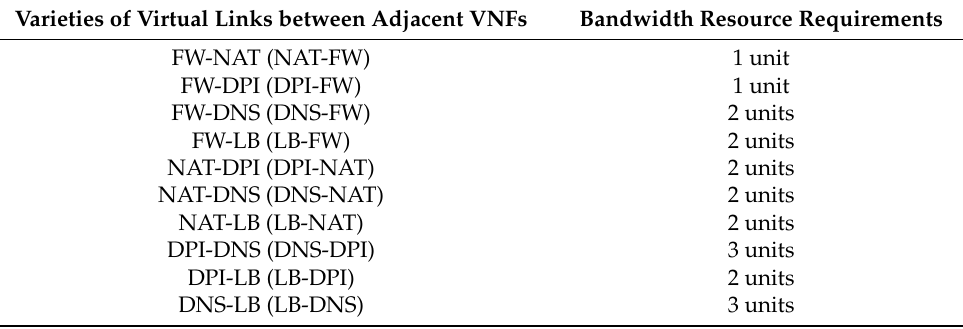
Table 3. All virtual links and their respective bandwidth resource requirements. Varieties of Virtual Links between Adjacent